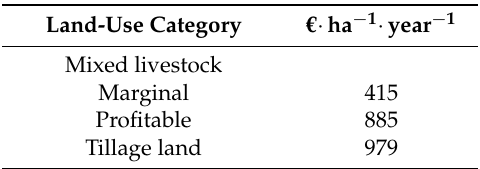
Table A4. Agricultural financial values used per land-use category. Source: Teagasc National Farm Survey 5-year average gross margin from year 2007 to 2011 inclusive [53–57].